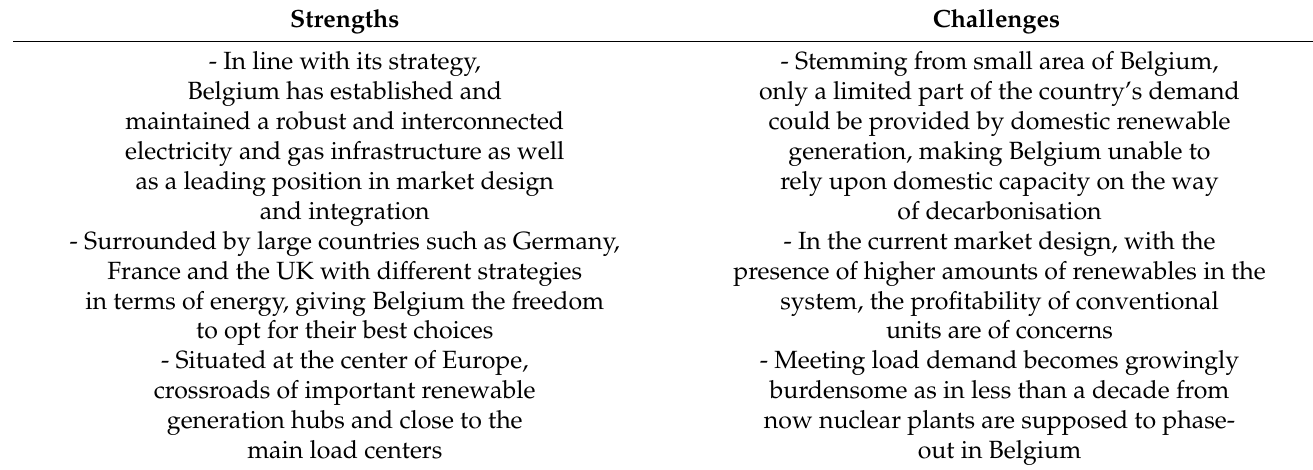
Table 4. Strengths and challenges of Belgium on the way to decarbonisation [152].